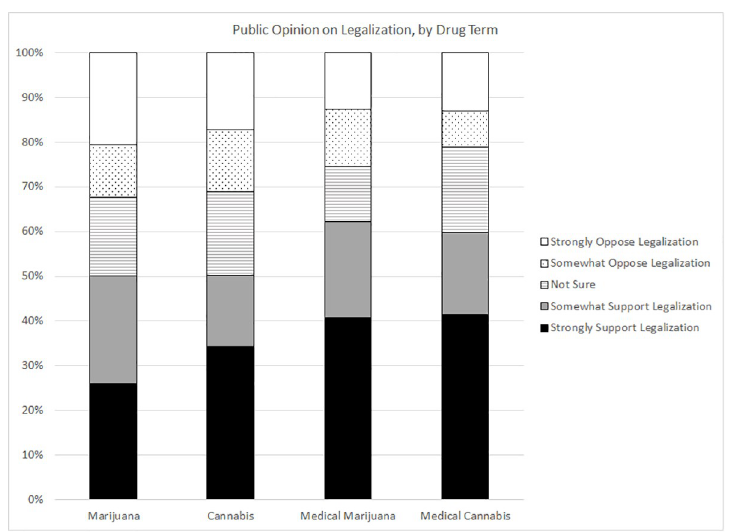
Fig 4. Public opinion on legalization by drug